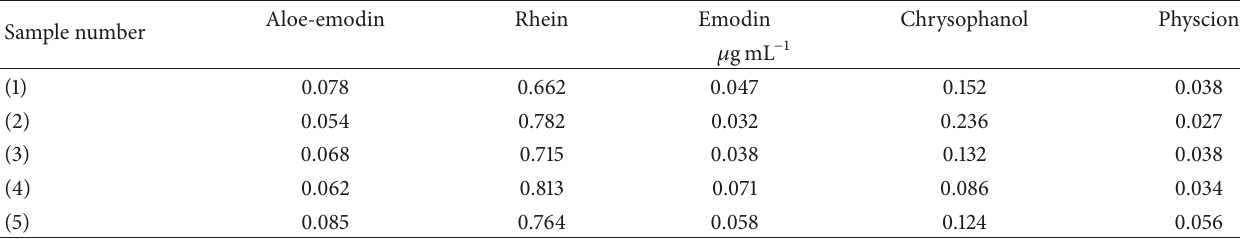
Table 3: Determination of anthraquinones in urine from five patients after oral rhubarb decoction.